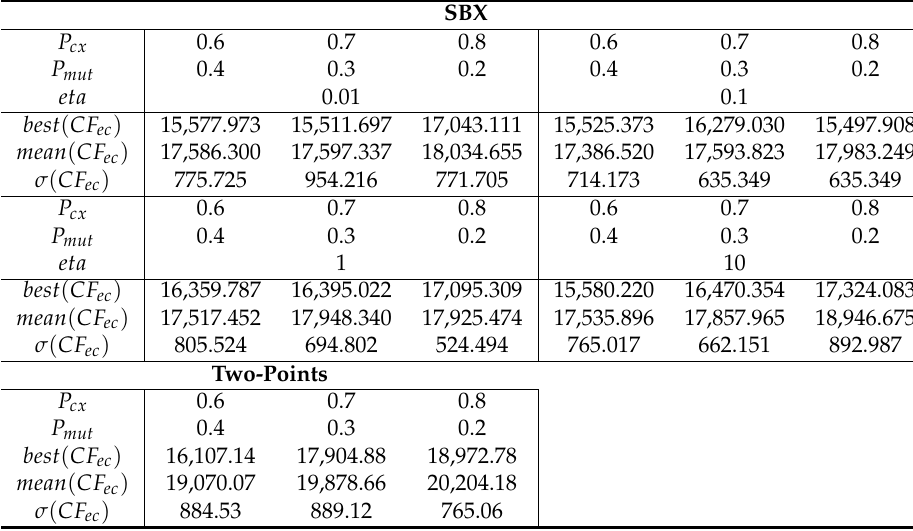
Table 7. Case-study 2